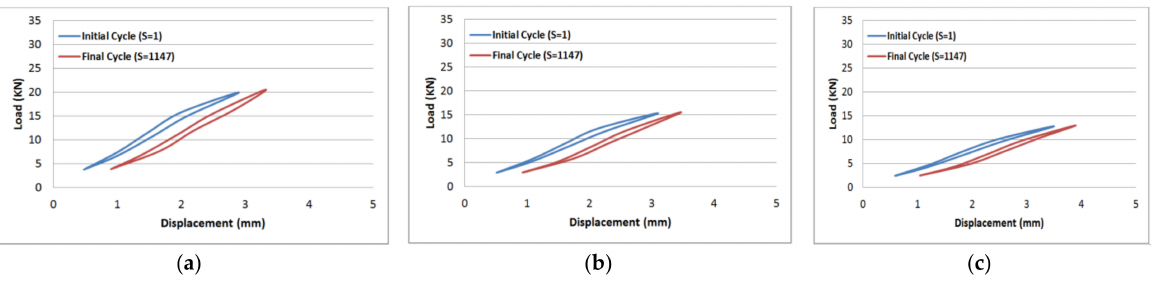
Figure 7. Load-displacement performance at 65% of the maximum load for fibre volume fraction ( a ) 50% glass fibre-reinforced polyester, ( b ) 35% glass fibre-reinforced polyester, and ( c ) 20% glass fibre-reinforced polyester.